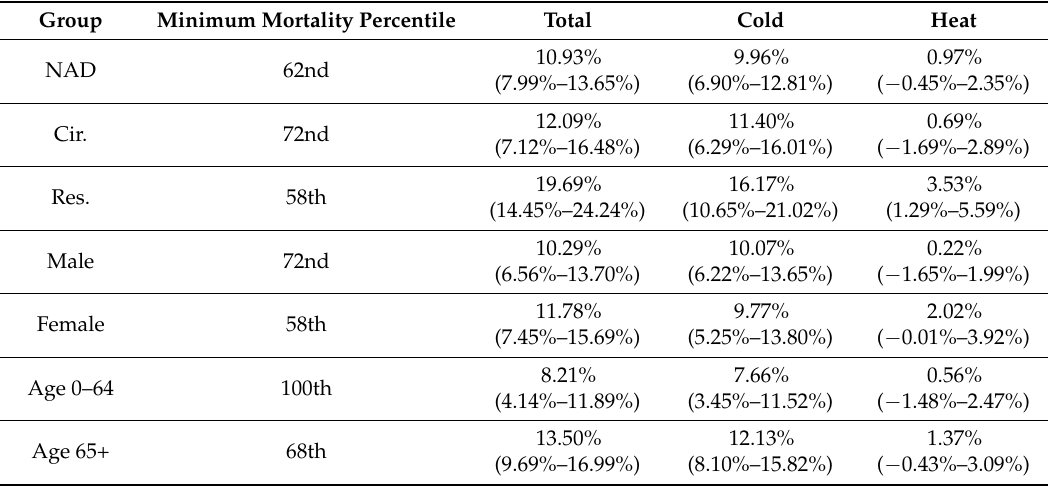
Table 2. Attributable mortality by disease causes, sex and age.